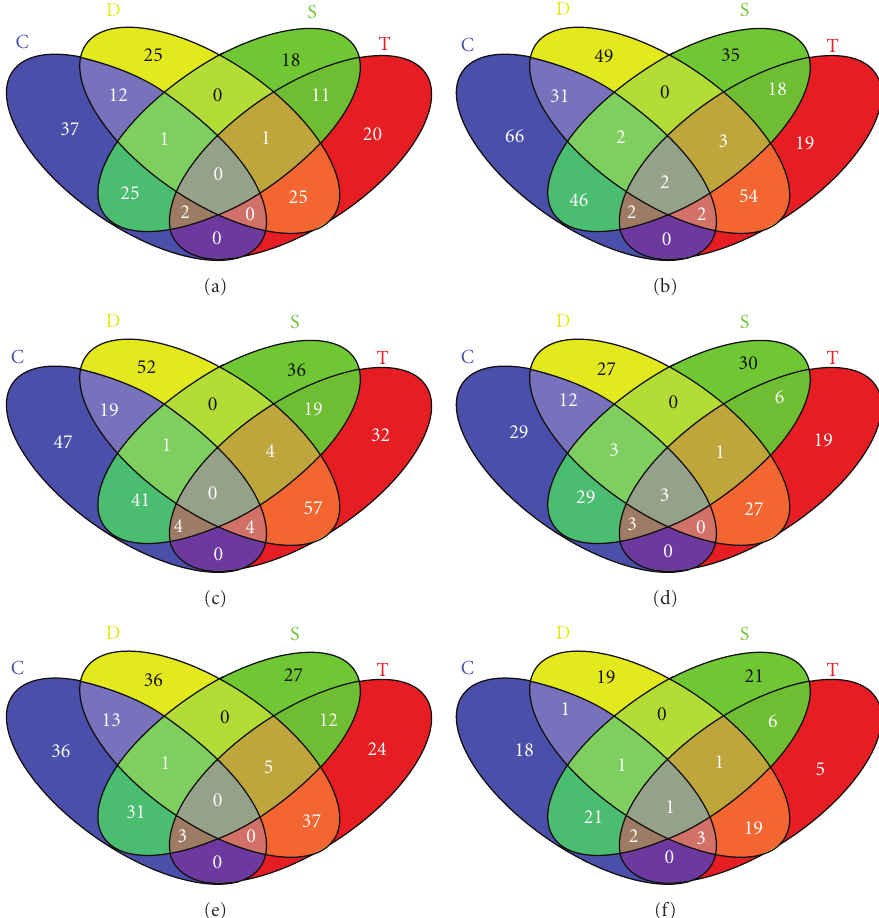
Figure 1: Venn diagrams with numbers of di ff erentially upregulated (UR) tags from sugarcane roots ( P ≤ 0 . 05) under drought stress, considering di ff erent comparisons between SuperSAGE libraries [contrasts: T (TD versus TC); S (SD versus SC); D (TD versus SD); C (TC versus SC)]. UR tags associated with gene ontology (GO) response to (a) water deprivation; (b) heat/cold; (c) osmotic stress; (d) oxidative stress; (e) abscisic acid stimulus; (f) jasmonic acid stimulus. Libraries: TD (drought tolerant bulk under stress); TC (tolerant bulk